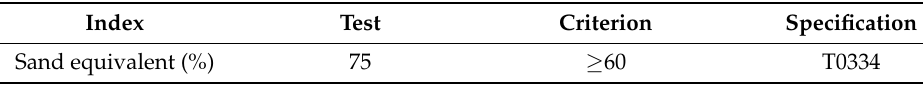
Table 2. Technical properties of the fine aggregate.